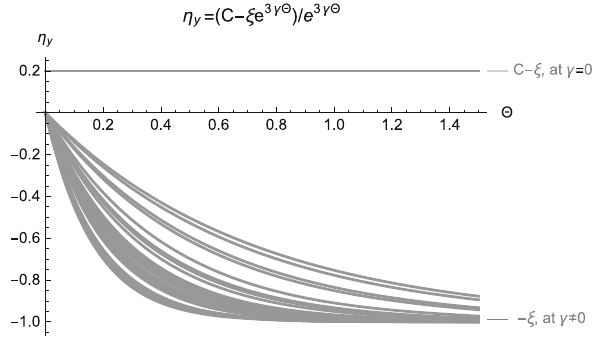
Fig. 4 Variation of η y with respect to (cid:16) for F 2